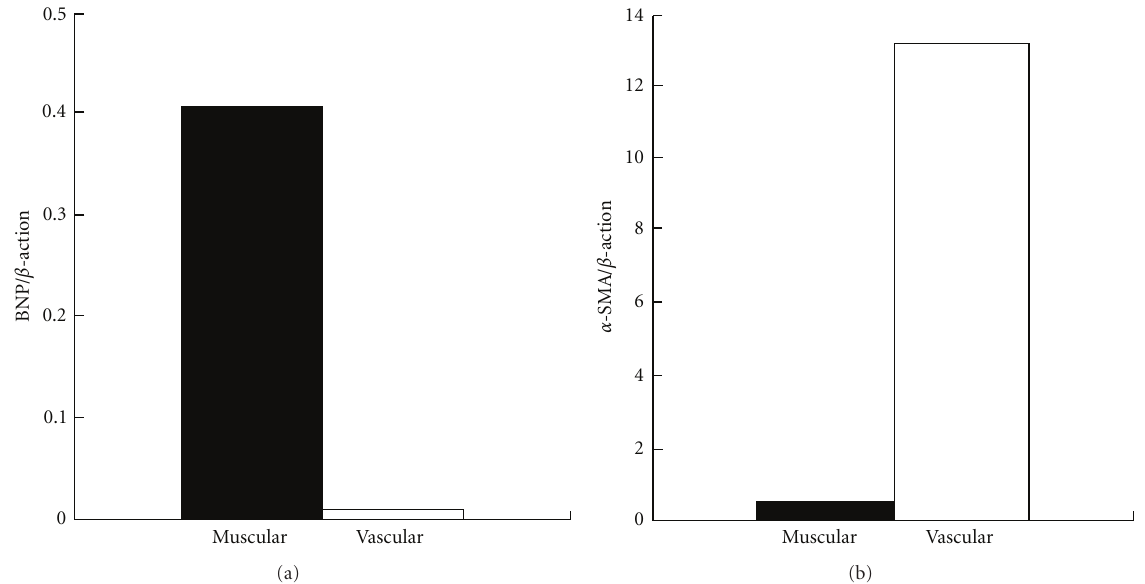
Figure 3: BNP and α -SMA mRNA expression in the muscular (closed column) and vascular (open column) samples obtained from the heart of WKY ( n = 2). Expression level of the target gene was normalized by β -actin level in each sample.